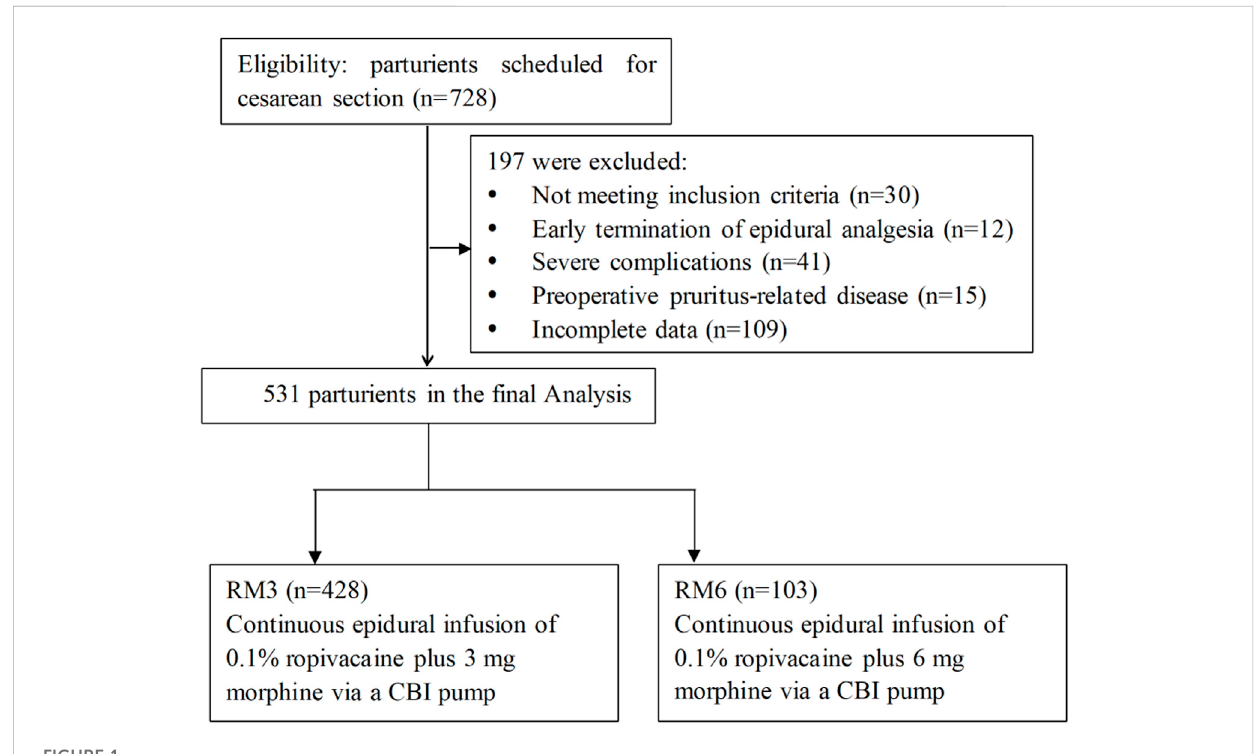
FIGURE 1 The fl ow diagram of the study protocol. CBI, continuous basal